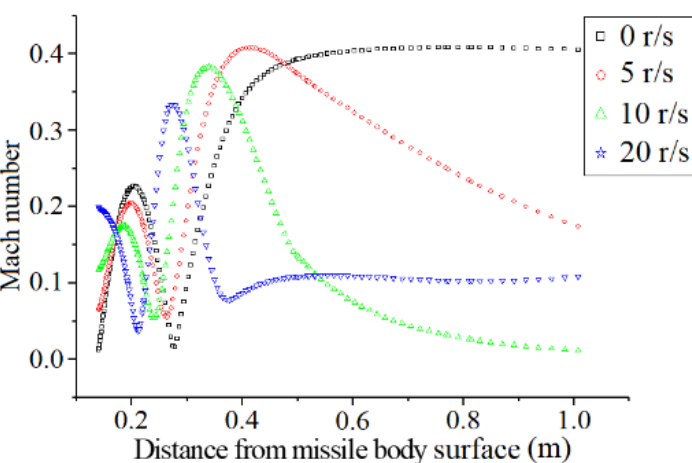
Figure 10. Mach number contours of two parallel external jets at different rotational angular veloc- ities: ( a ) 0 r/s, ( b ) 5 r/s, ( c ) 10 r/s, ( d ) 20 r/s.